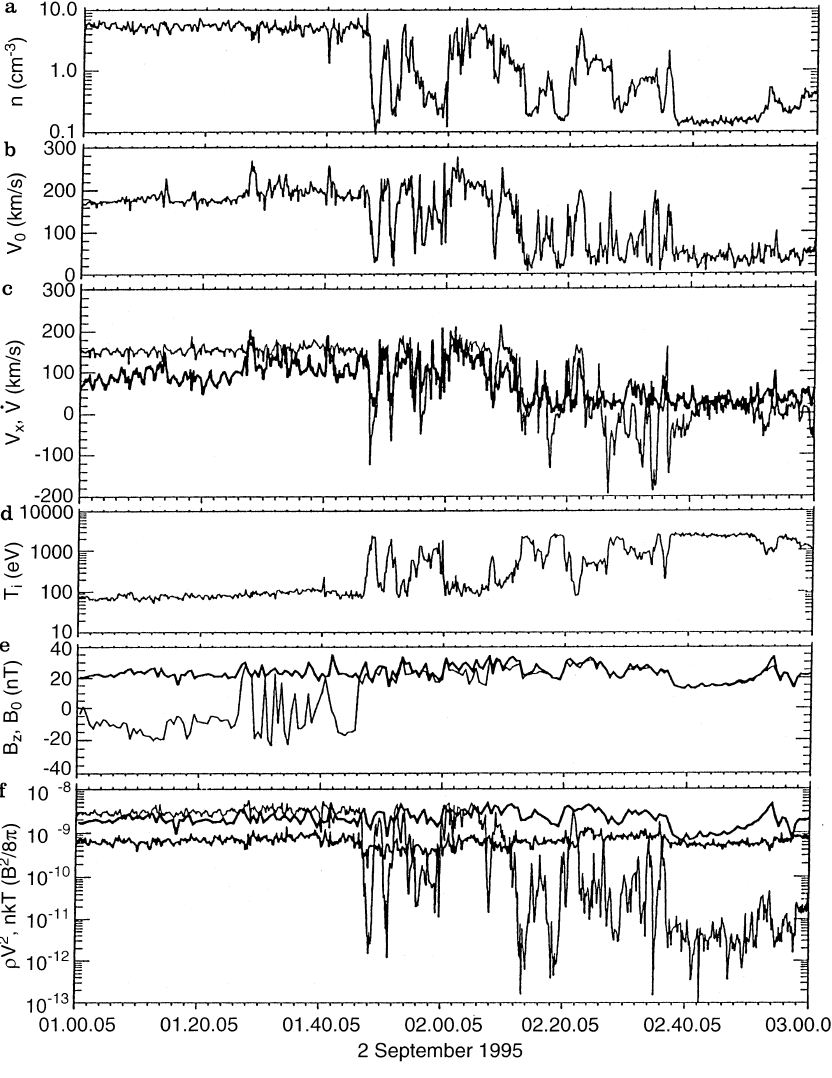
Fig. 9a–f. Comparison of plasma and magnetic-field parameters and some de- rived parameters for magnetopause crossing on 2 September 1995. a proton number density N ; b total velocity V o , c V x ( thin curve ) and transverse V t ( thick line ) velocity components, d ion temper- ature, e magnetic field magnitude B o ( thick line ) and B z ( thin line ) component (from FM-3 magnetometer data), f plasma ram pressure, P d (cid:136) (cid:113) V 2 ( thin line ), ion thermal pressure, NkT i , ( lower thick line ) and magnetic-field pressure, P m (cid:136) B 2 /8 (cid:112) ( upper thick